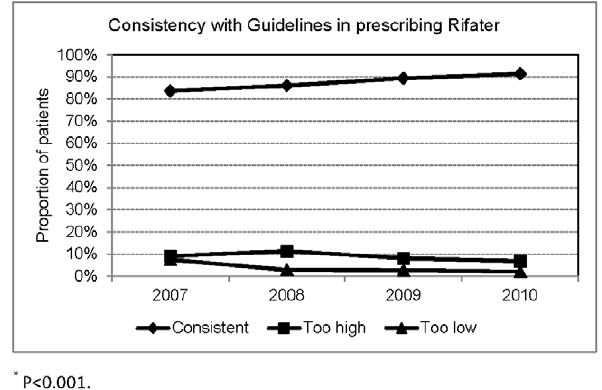
Figure 2. Consistency with Taiwan Guidelines in prescribing Rifater.